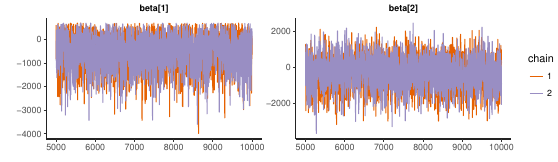
Figure 8 – The plots of trace of the MO-G